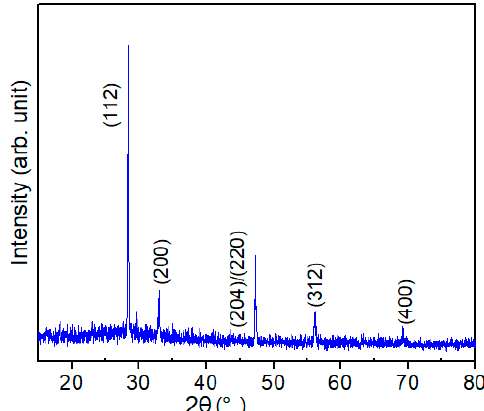
ff raction (XRD) pattern of a typical Cu Figure 1. X-ray diffraction (XRD) pattern of a typical Cu 2 ZnSnS 4 (CZTS) film. Figure 1. X-ray di